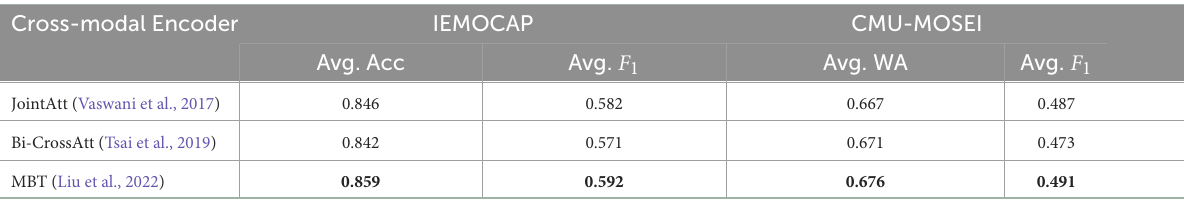
TABLE 5 Audio-visual emotion recognition results using different cross-modal